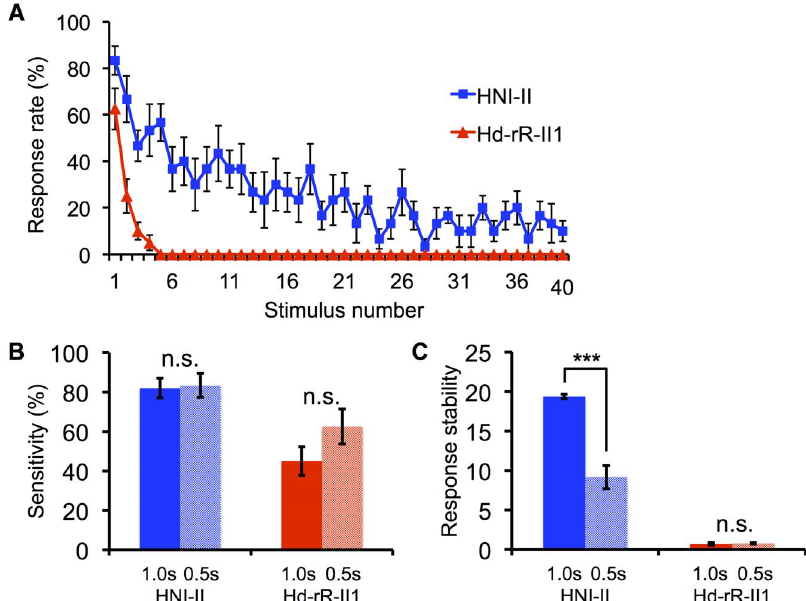
Figure 3. Comparison of Startle Response Properties between Different Stimulus Interval Conditions. HNI-II (n=6), Hd-rR-II1 (n=8). (A) Transition of response probability to frequent (0.5-s interval) stimulus presentation. (B) Sensitivity in different stimulus interval conditions. Bars represent SEM. In each inbred strain, no significant difference was detected between the 1.0-s and 0.5-s interval conditions, based on one-way ANOVA. (C) Response stability index of two inbred strains. Bars represent SEM. ***p , 0.001 by one-way ANOVA.